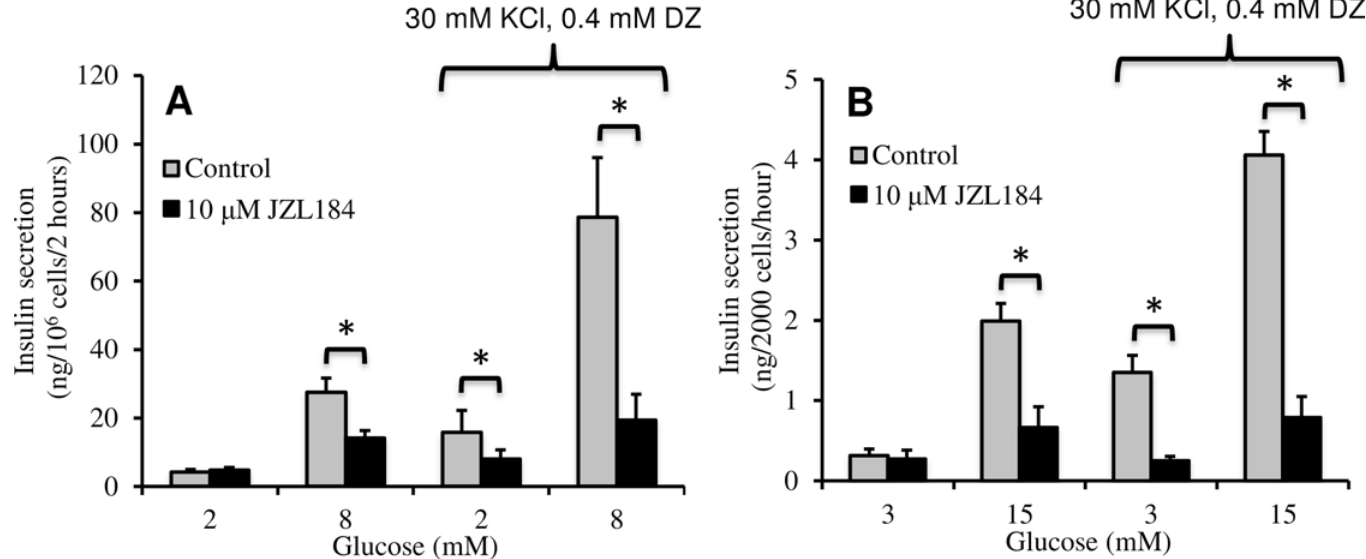
Fig 3. JZL184 inhibited KCl-induced insulin secretion. Insulin secretion from batch incubations of (A) INS-1 cells and (B) dissociated rat islets (n = 3 independent experiments for both A and B). Error bars represent S.E. ( * , p < 0.05).